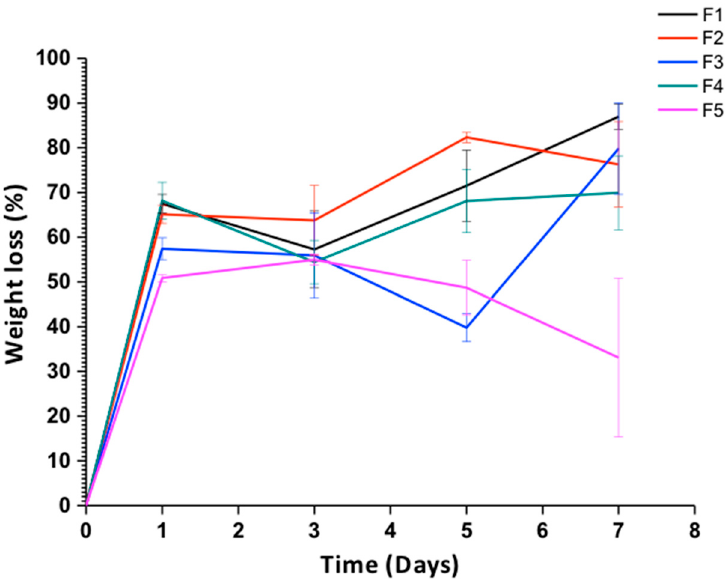
Figure 7. Weight loss vs. time. F1: CS/PVA/GO 20:80:0; F2: CS/PVA/GO 14.75:85:0.25; F3: CS/PVA/GO 19.5:80:0.5; F4: CS/PVA/GO 14.25:85:0.75 and F5: CS/PVA/GO 29:70:1. All the ratios are wt %. Data are shown as mean ± standard deviation of the mean ( n = 3).